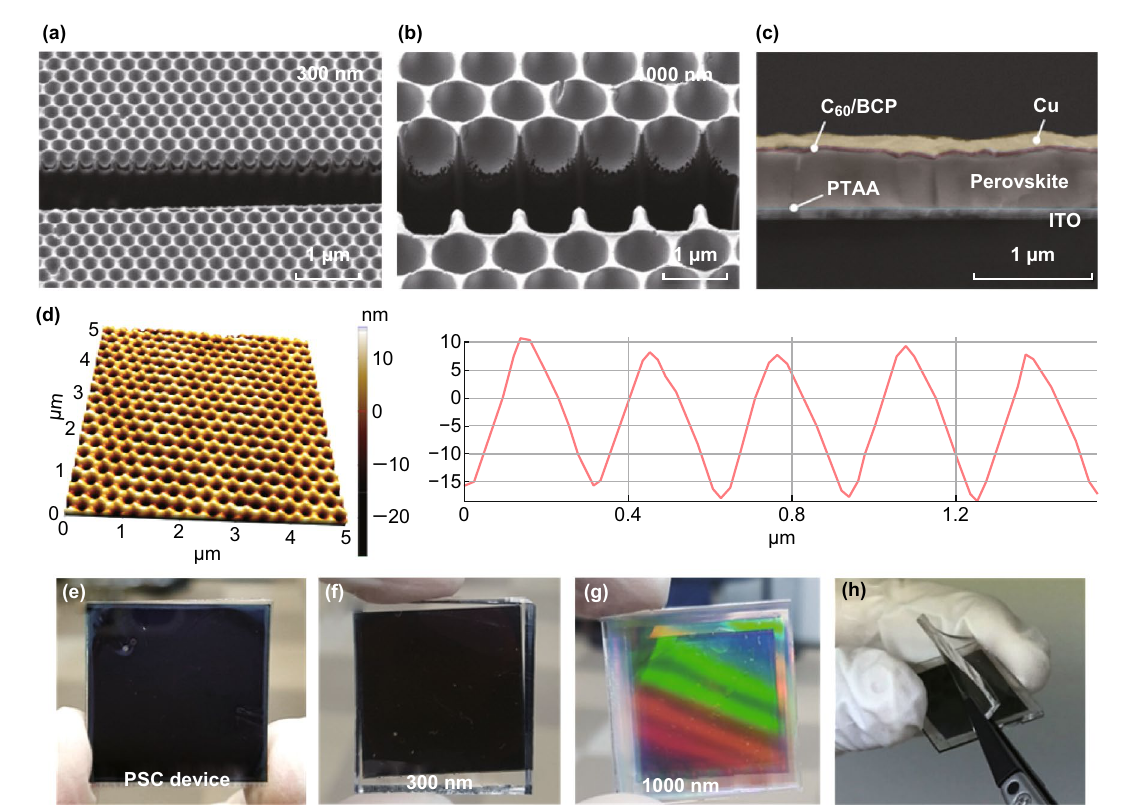
Fig. 2 FIB‑assisted cross‑sectional SEM images of a 300‑nm moth‑eye PDMS film, b 1000‑nm moth‑eye PDMS film, and c PSC configuration imaged in BSE mode. d AFM image and line profile of 300‑nm moth‑eye PDMS film. Digital camera images of e completed PSC device, f PSC with 300‑nm moth‑eye PDMS film, g PSC with 1000‑nm moth‑eye PDMS film, and h detachment of 300‑nm moth‑eye PDMS film from